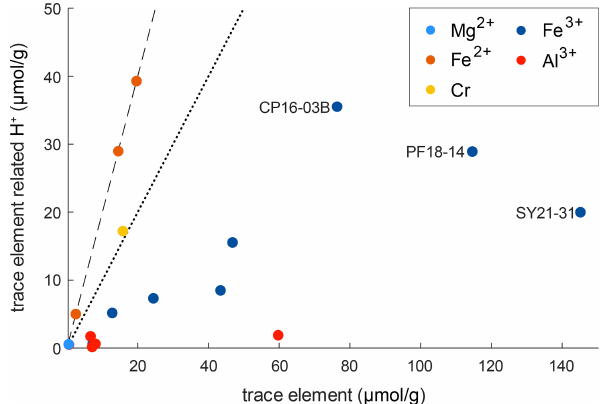
Figure 10. Molar trace-element content vs. trace-element-related H + content. The dotted line represents a 1:1 ratio between H + and related trace element that would denote a perfect balance of H + and trivalent cations. The dashed line represents a 2:1 ratio between H + and related trace element that would denote a perfect balance of H + and divalent